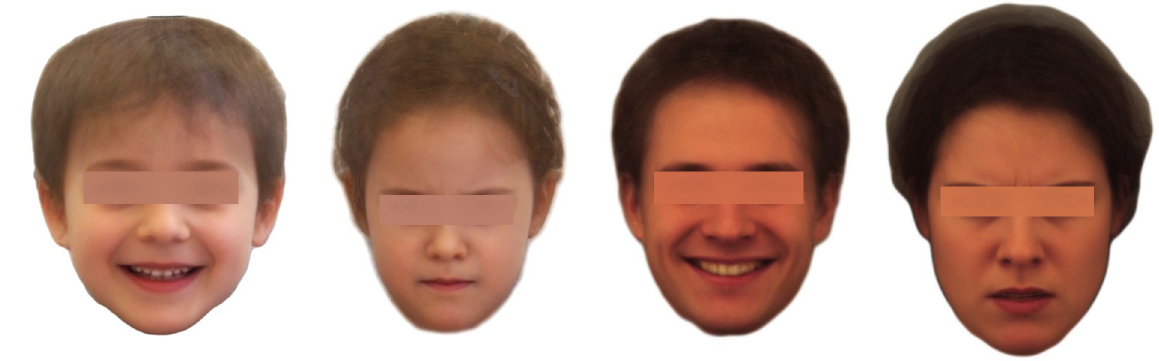
Fig 2. Examples of the 28 prototypical reference portraits of the basic affects happiness (child, male), anger (child, female), happiness (adult, male) and anger (adult, female) (from left to right).